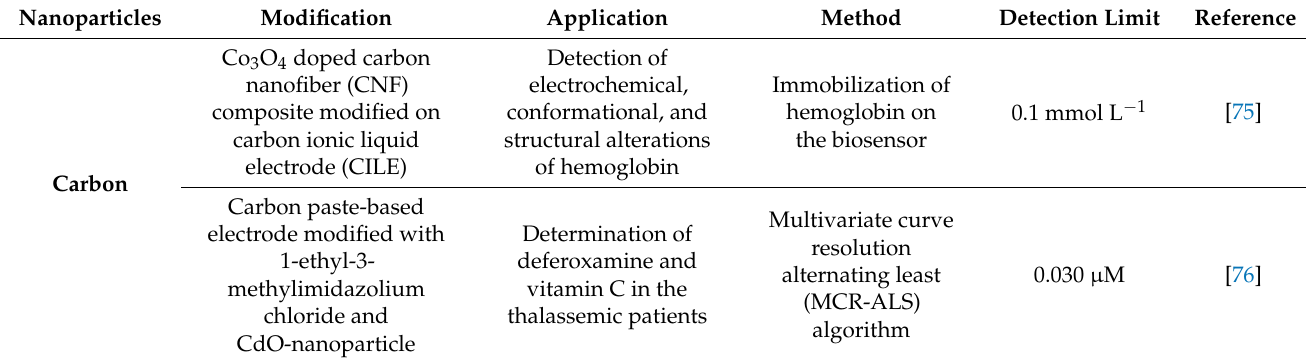
Table 2. Nanotechnology-based diagnostic approaches for